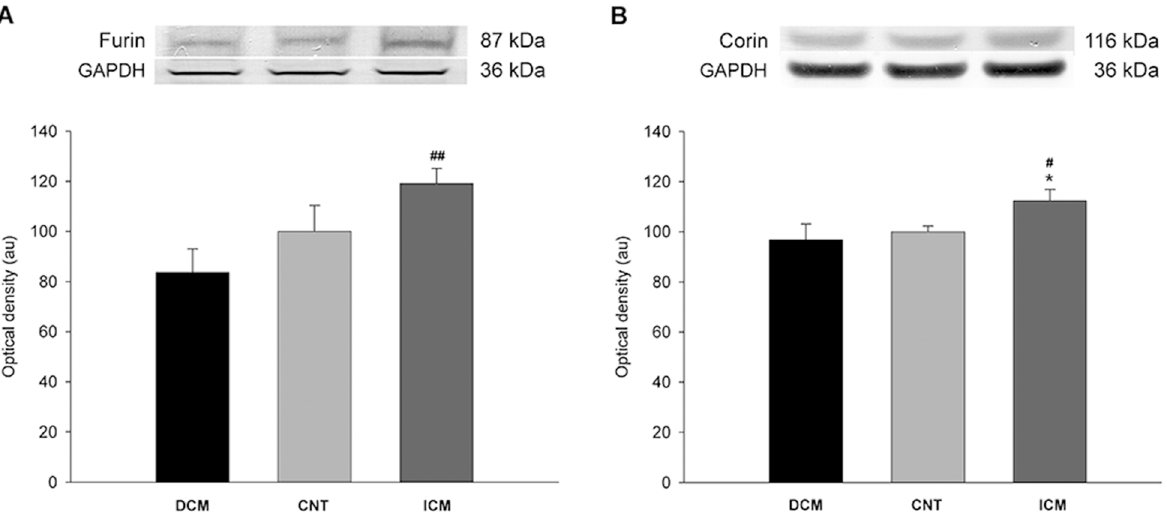
Figure 2. Protein expression levels of endoproteases in the dilated (DCM) and ischemic (ICM) cardiomyopathy, and control (CNT) groups. A, furin; B, corin. The values from the CNT group were set to 100. The data are expressed as mean 6 SEM in arbitrary units (optical density) of 2 independent experiments. *p , 0.05 vs. the CNT group; # p , 0.05, ## p , 0.01 DCM vs. the ICM group.